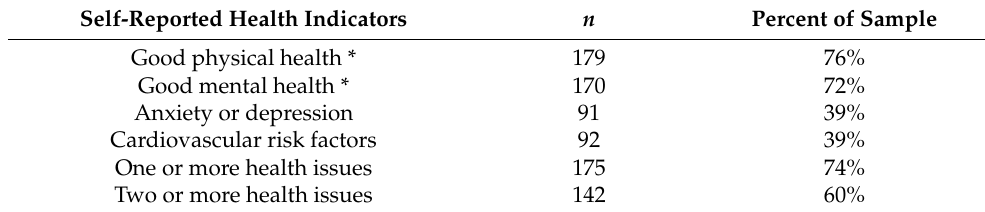
Table 2. Community Health Indicators ( n = 236). Self-Reported Health Indicators n